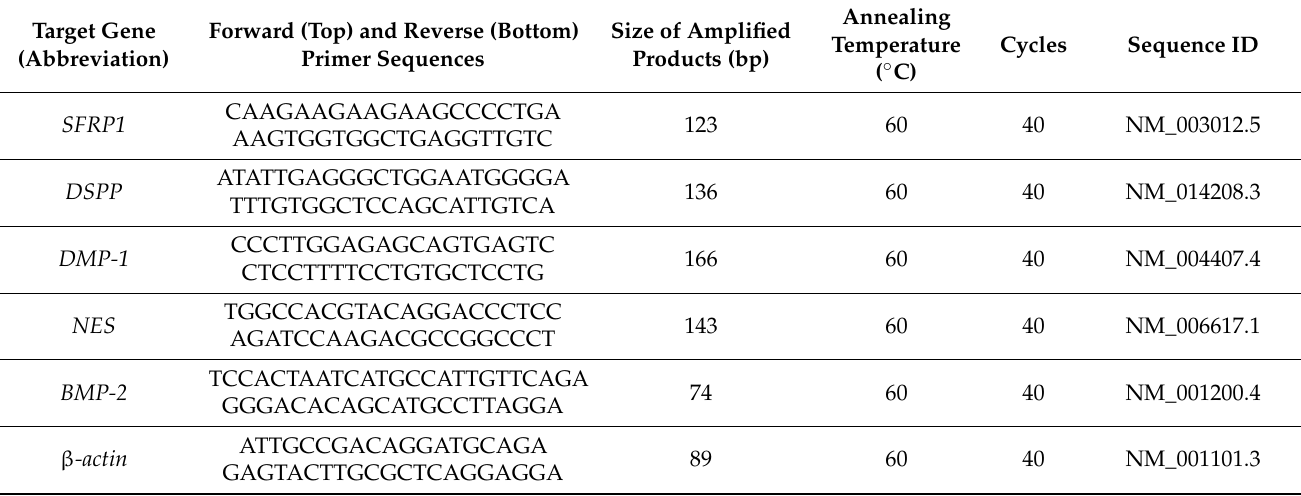
Table 2. Specific primer sequences, annealing temperature, cycle numbers, product sizes, and sequence IDs for quantitative